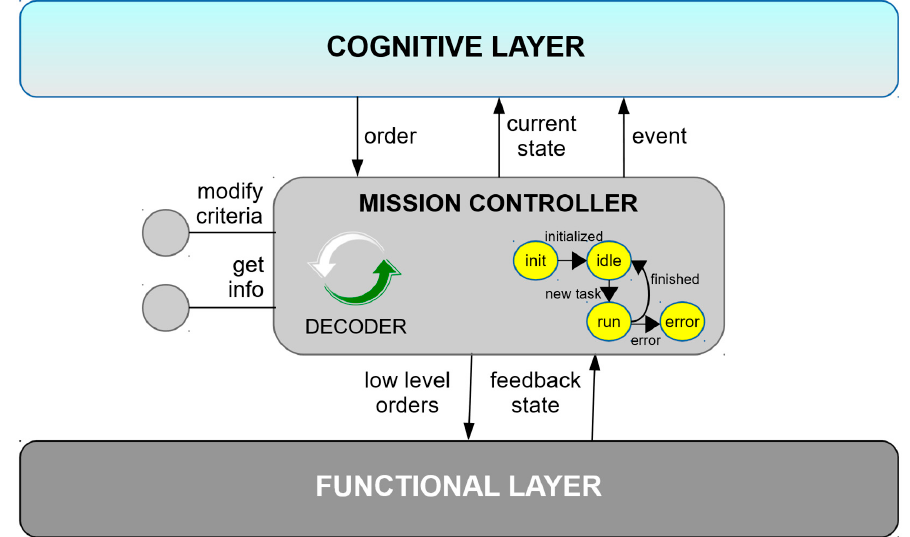
Figure 3. Mission Controller component (operative layer).